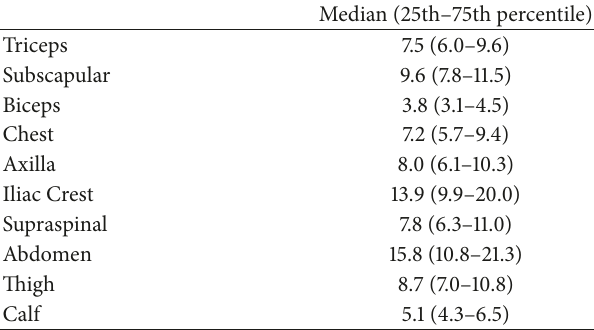
Table 3: Subjects’ skinfold thicknesses ( 𝑛 = 131 ),